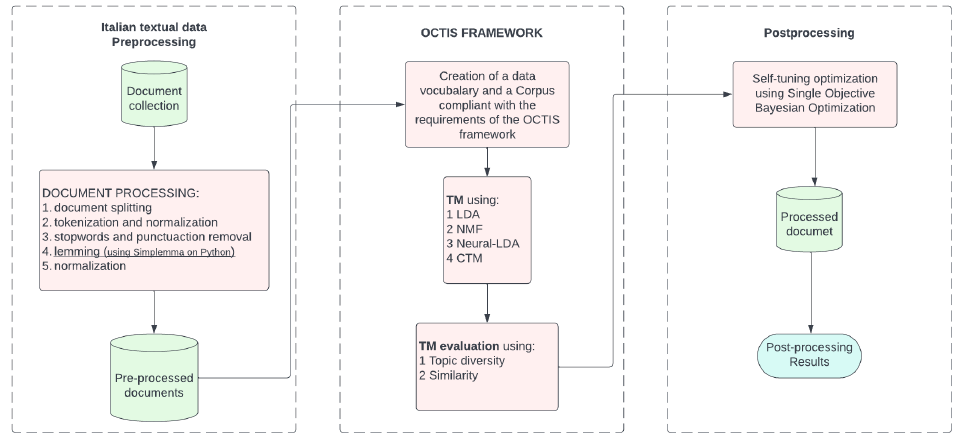
Figure 8. Process–work schema of 3 steps (from left to right): (1) pre-processing of the data in Italian natural language; (2) OCTIS framework; (3) post-processing for